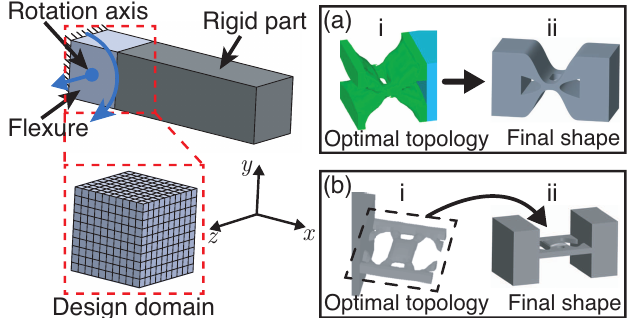
Figure 15. Schematic description of the Topology Optimization process to design the optimal configuration of SARFJ using a 3D cubic design domain. Optimal designs obtained in ( a ) i-optimal topology and ii-final shape (Adapted with permission from ref. [220]. 2021, Elsevier), ( b ) i-optimal topology and ii-final shape (Adapted from ref. [221]. 2020,